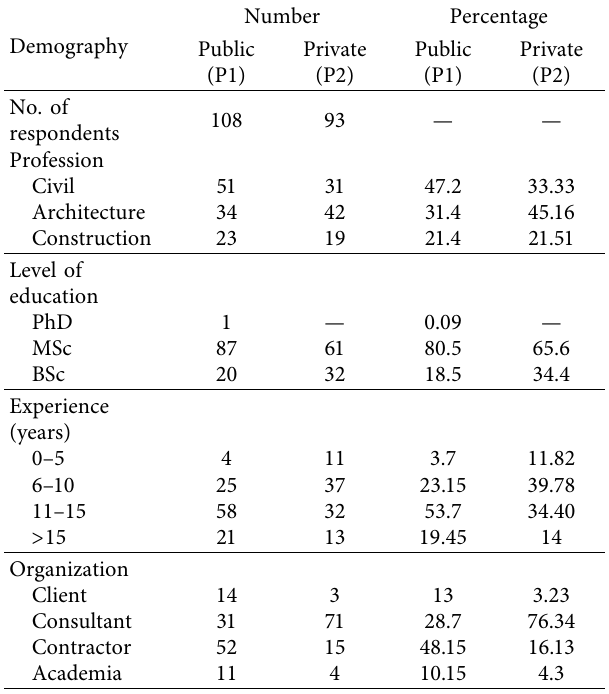
Table 5: Demographic summary of